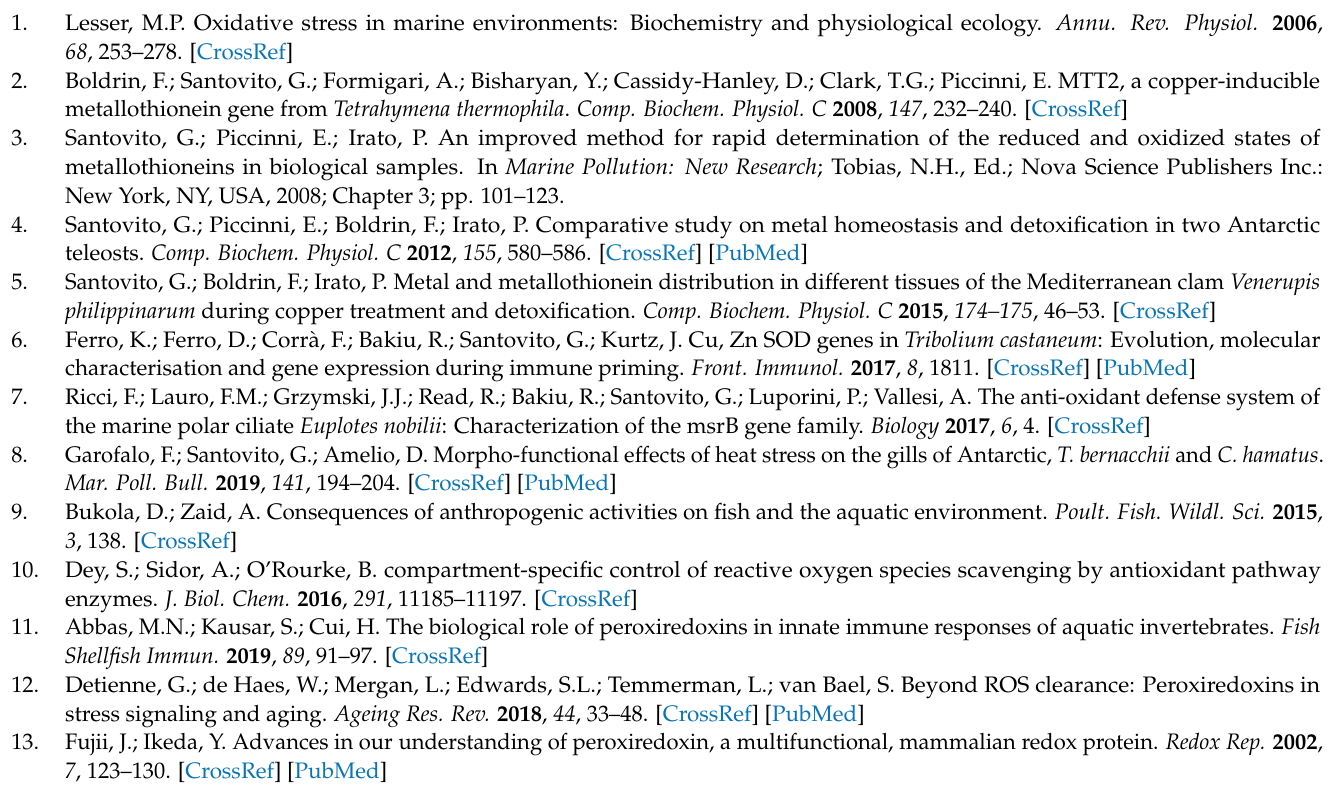
Figure S7: Phylogenetic relationships among Prdx isoforms of various organisms reconstructed on the amino acid sequences and using both Bayesian interference (BI) and Maximum likelihood (ML) methods. Bayesian posterior probability (first number) and bootstrap values higher (and equal to) than 50% are indicated on each node, respectively. The scale for branch length (2.0 substitution/site) is shown below the tree, Table S1: Primer sequences, and relative melting temperatures (Tm), used for reverse transcription (Oligo-dT anchor primer) and for PCR amplification, Table S2: Primer sequences, and relative melting temperatures (Tm), used for qRT-PCR amplification, Table S3. GenBank accession numbers and ANISEED transcript IDs ( Ciona robusta , Ciona intestinalis and Botrylloides leachii ) referred to amino acid sequences of Prdx2, Prdx3 and Prdx4 used for multi-alignment and phylogenetic analyses, Table S4: Percentages of identity, similarity and E-values obtained by comparing Cr-Prdx2 amino acid sequence with orthologous sequences of metazoans, Table S5: Percentages of identity, similarity and E-values obtained by comparing Cr-Prdx3 amino acid sequence with orthologous sequences of metazoans, Table S6: Percentages of identity, similarity and E-values obtained by comparing Cr-Prdx4 amino acid sequence with orthologous sequences of